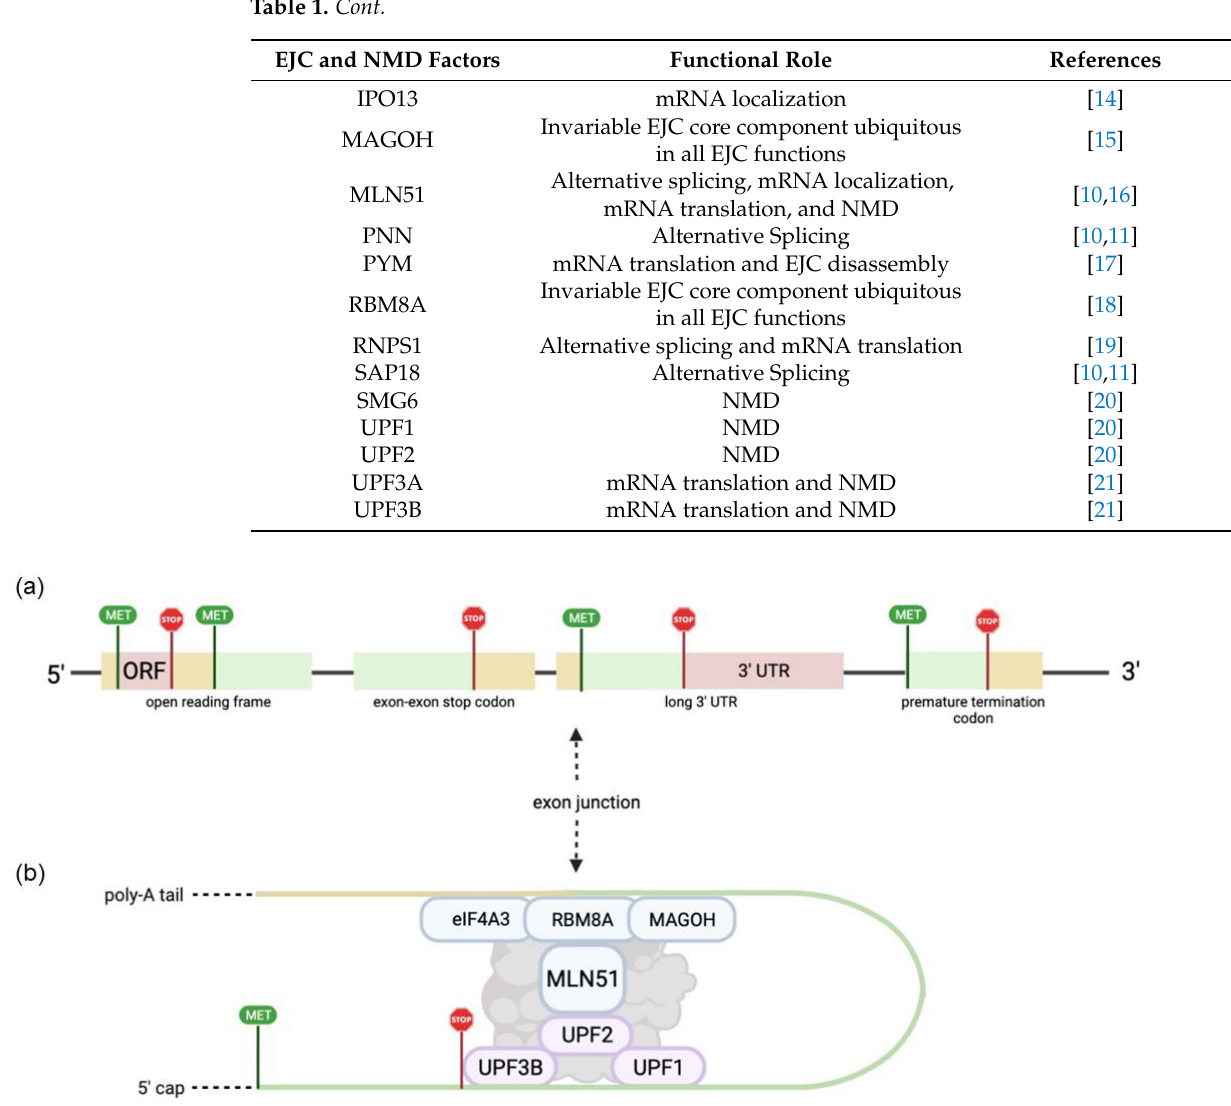
Figure 1. Graphical representation of EJC binding in mRNA during NMD. ( a ) NMD features that often trigger mRNA degradation, include upstream open reading frames, exon-exon stop codons, a long 3′ UTR, and a premature termination codon. ( b ) NMD cofactors UPF3B, UPF2, and UPF1 bind upstream of the exon junction, triggering exon-junction complex binding and NMD. Only core EJC factors are shown.